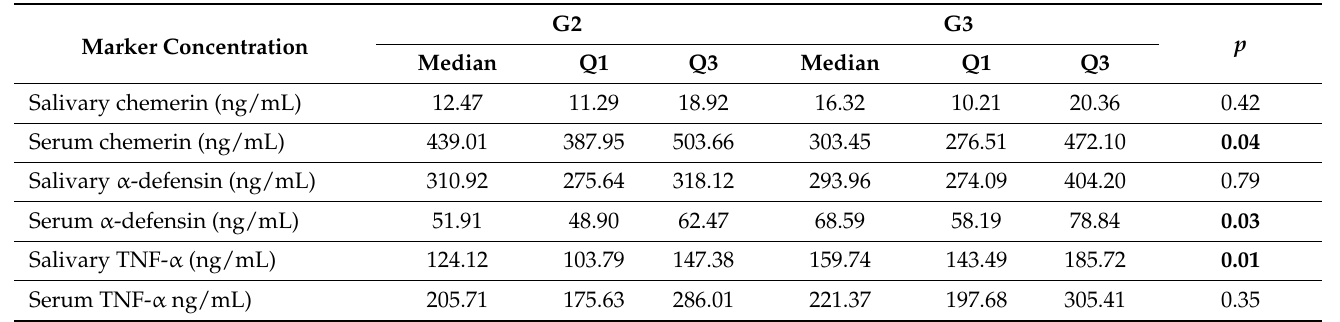
Table 7. Correlation between serum and salivary concentrations of chemerin, α -defensin 1, and TNF- α and the tumor grade